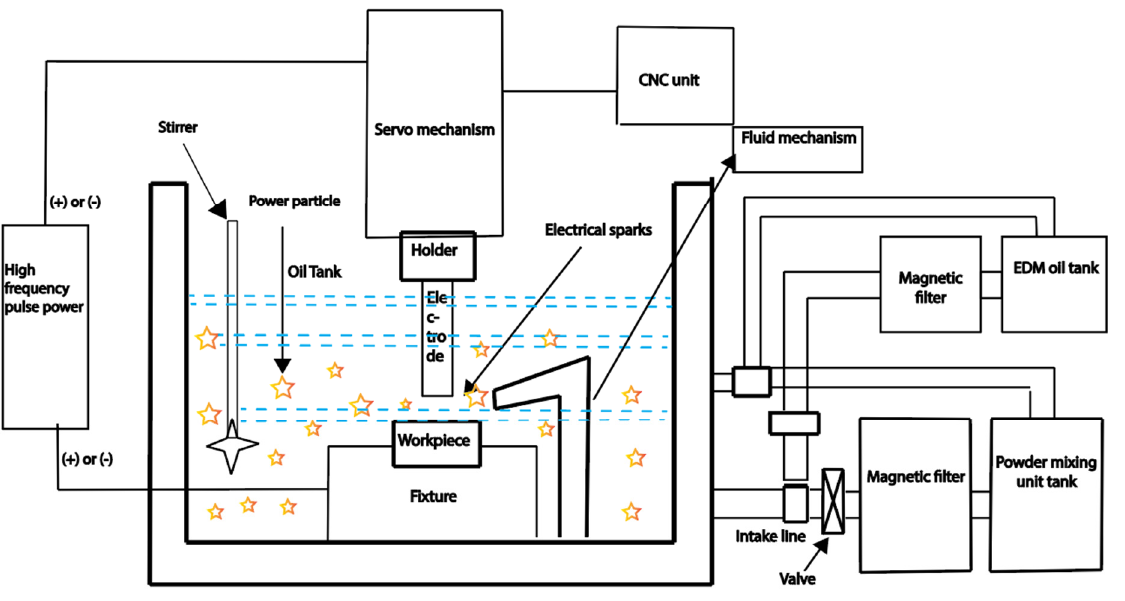
Figure 12. Schematics of the PMEDM process [232] .